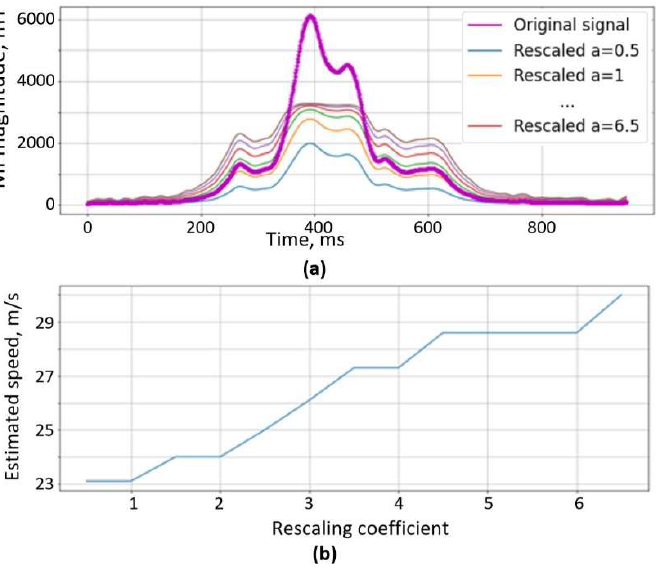
Figure 6. ( a ) Original signal (purple) with rescaled signals, ( b ) speed versus a